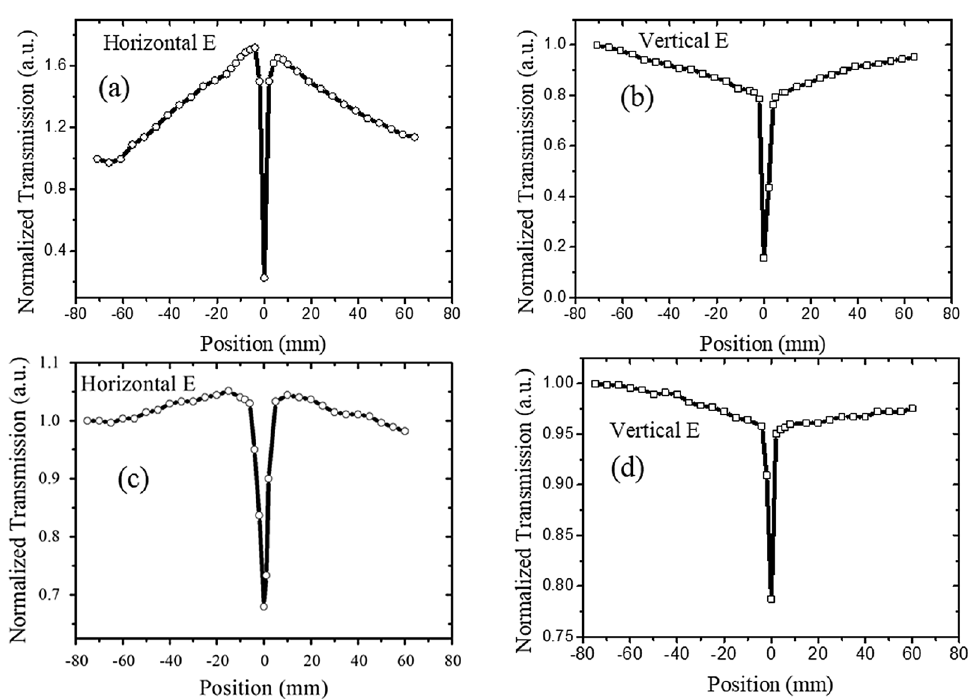
Figure 3. Z-scan results of GO in NMP. (a,b) 527-nm laser with 50 mW power; transmission of graphene suspension is 10%; cuvette is 5 mm wide; (c,d) 527-nm laser with 50 mW power; transmission of graphene suspension is 60%; cuvette is 10 mm